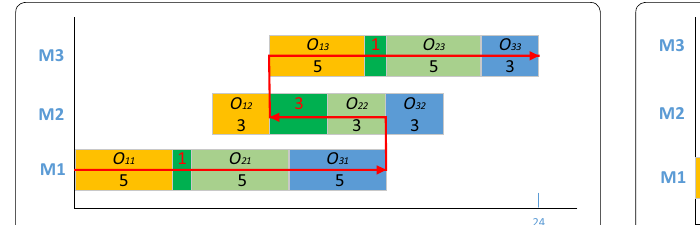
Figure 9 The critical path in the Gantt chart of NIFSP